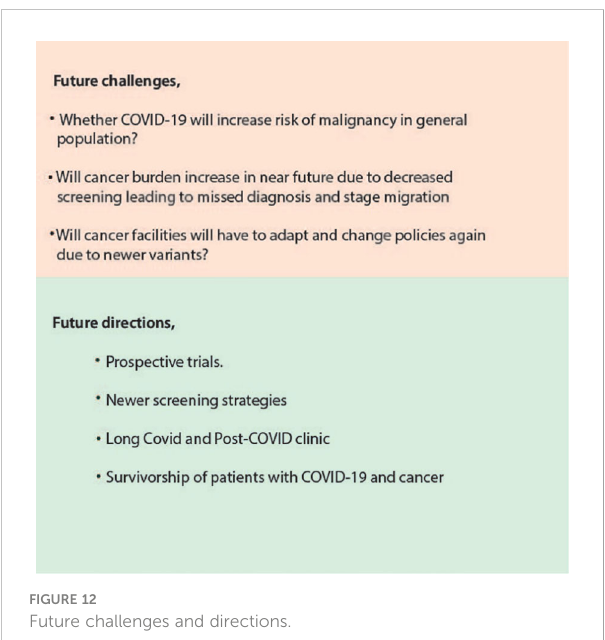
FIGURE 12 Future challenges and